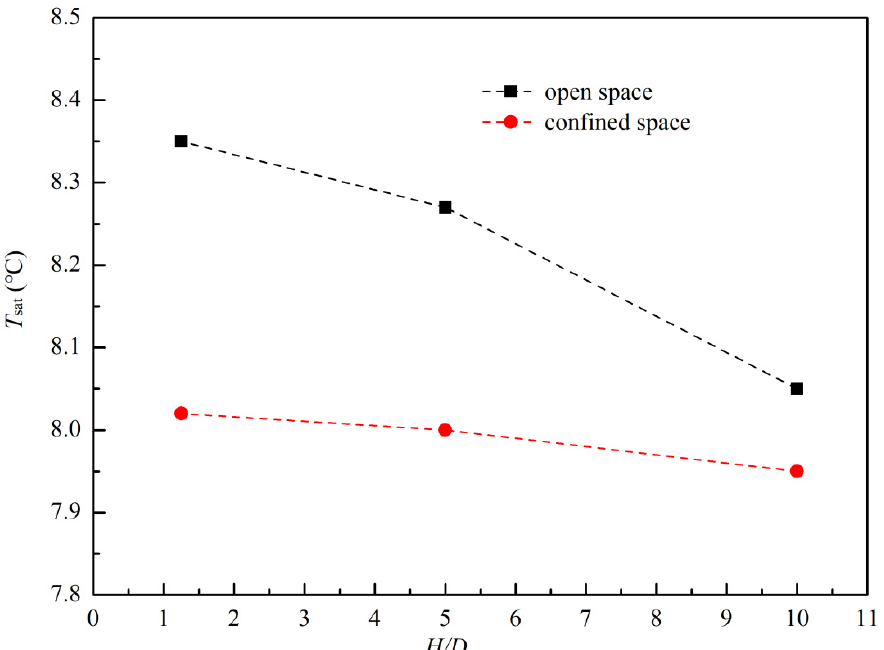
Figure 13. Comparison of wall super-heat temperature between restricted space and open space.